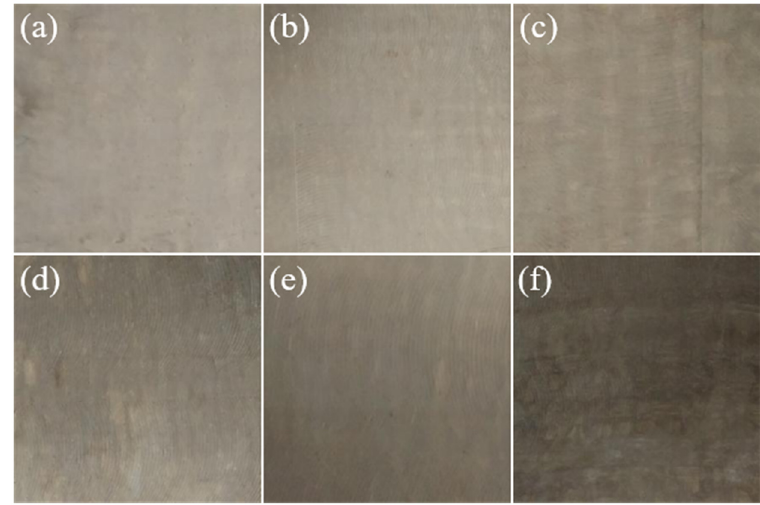
Figure 11. Surfaces of glass fibre reinforced polyphenylene sulphide composites at different moulding temperatures. ( a ) 300 ◦ C ( b ) 305 ◦ C ( c ) 310 ◦ C ( d ) 315 ◦ C ( e ) 320 ◦ C ( f ) 325 ◦ C.